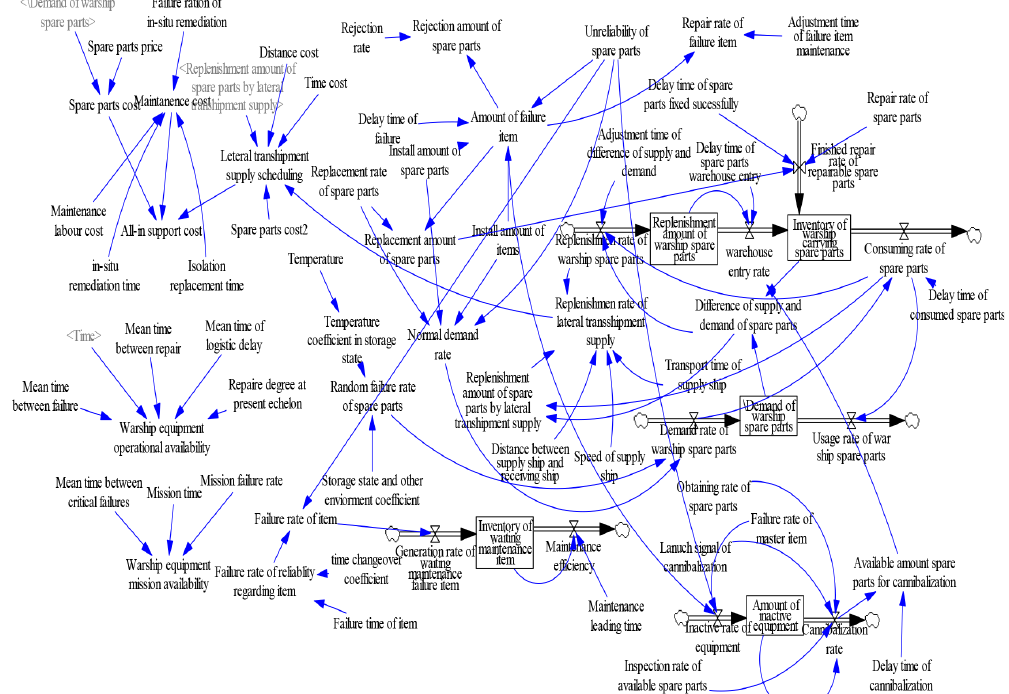
Figure 4. Warship spare parts support system dynamics